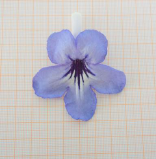
Figure 1. ”Natalie” variety. Figure 1. “Natalie”